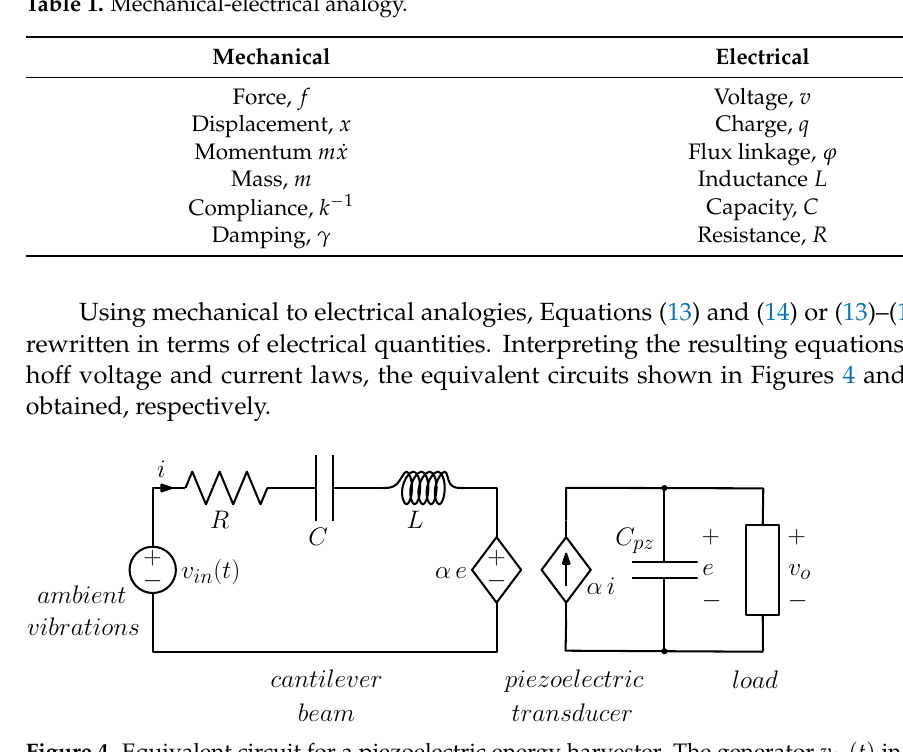
Figure 4. Equivalent circuit for a piezoelectric energy harvester. The generator v in ( t ) in the circuit corresponds to the external force f m ( t ) .